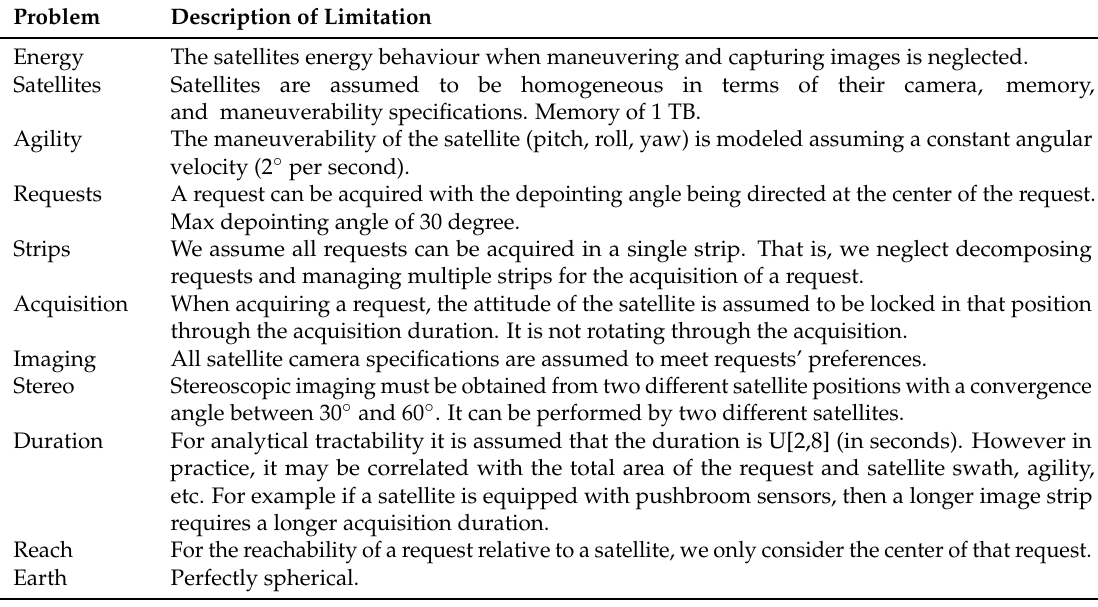
Table 2. Delimitation of